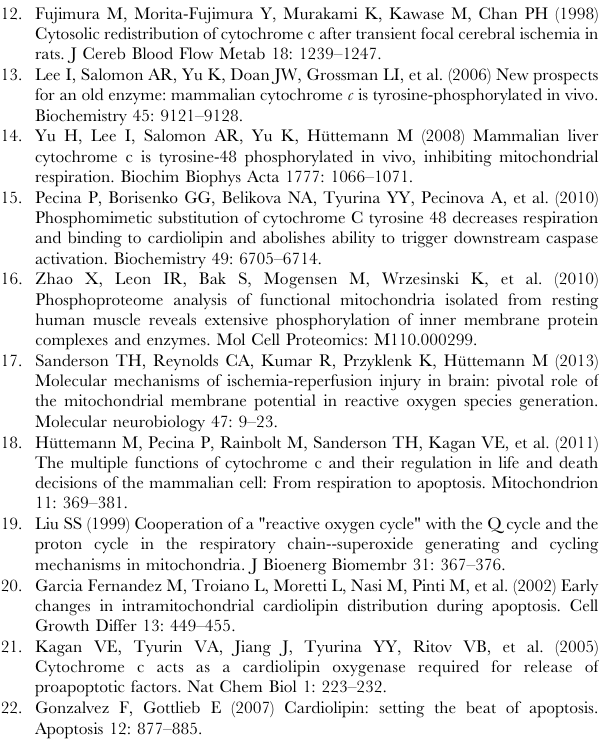
Figure 5. In vivo induction of cytochrome c Tyr97 phosphorylation in rat brain by insulin treatment. (A) Cyt c was isolated from rat brain after global brain ischemia (lane 1), from untreated control rats (lane 2), from sham-operated animals after insulin treatment (lane 3), and from rat brain after ischemia with insulin treatment (lane 4). Top, Western blot with an anti-phosphotyrosine antibody (4G10) reveals no detectable tyrosine phosphorylation of brain Cyt c under control conditions and after global brain ischemia (lanes 2 and 1, respectively), whereas tyrosine phosphorylation of Cyt c is strongly induced after insulin treatment (lane 3), but slightly reduced by ischemic stress (lane 4). Bottom, Coomassie gel shows equal loading (1 m g per lane) and purity of the isolated Cyt c species. (B) Nano-LC/ESI-MS/MS analysis of rat brain Cyt c after insulin treatment (corresponding to lane 3 in Fig. 5A) unambiguously identifies Tyr97 phosphorylation by fragment ions y3, y4, y5, and y6. The sequence of the peptide was definitively assigned by b3, b4, y2, y3, y4, y5, and y6. (C) Nano-LC/ESI-MS/MS analysis of rat brain Cyt c after global brain ischemia and insulin treatment (corresponding to lane 4 in Fig. 5A) unambiguously identifies Tyr97 phosphorylation by fragment ions y3, y4, y6, and y7. The sequence of the peptide was definitively assigned by b3, b4, y3, y4, y6, and